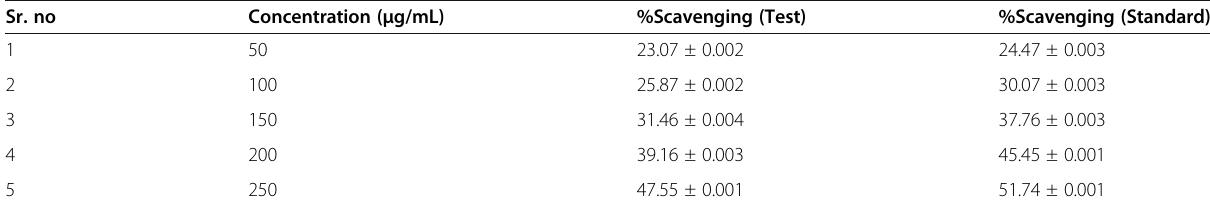
Table 5 Scavenging of hydrogen peroxide radicals of MELCL Sr. no